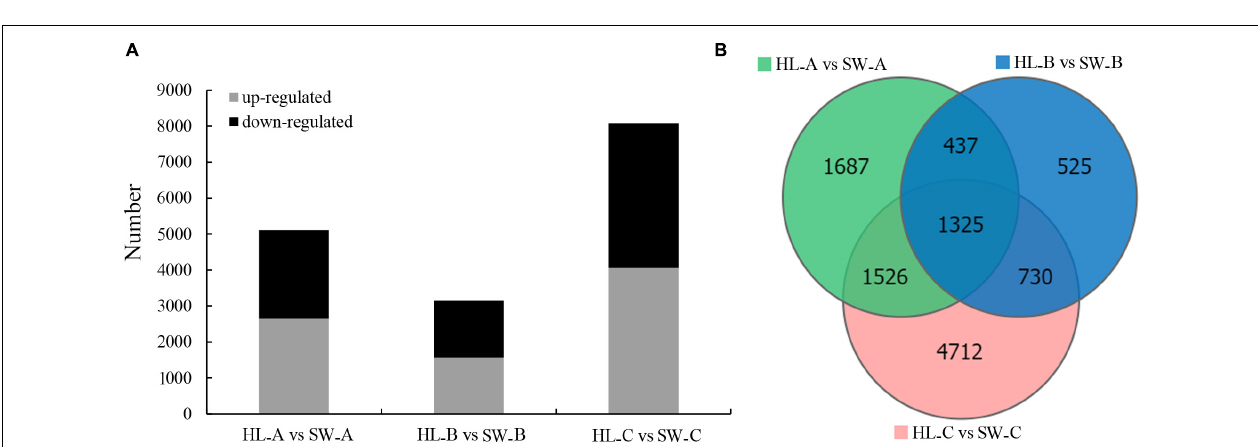
FIGURE 3 | Pearson’s correlation matrix (A) and principle component analysis (PCA) (B) of differentially expressed genes (DEGs) were performed on three biological replicates of each sample sets to evaluate correlations and variance between samples. “HL” and “SW,” “HongLi” and “Shuhe_Wuyingli” cultivars, respectively; A/B/C: bud infestation stage infestation/growth/maturation.